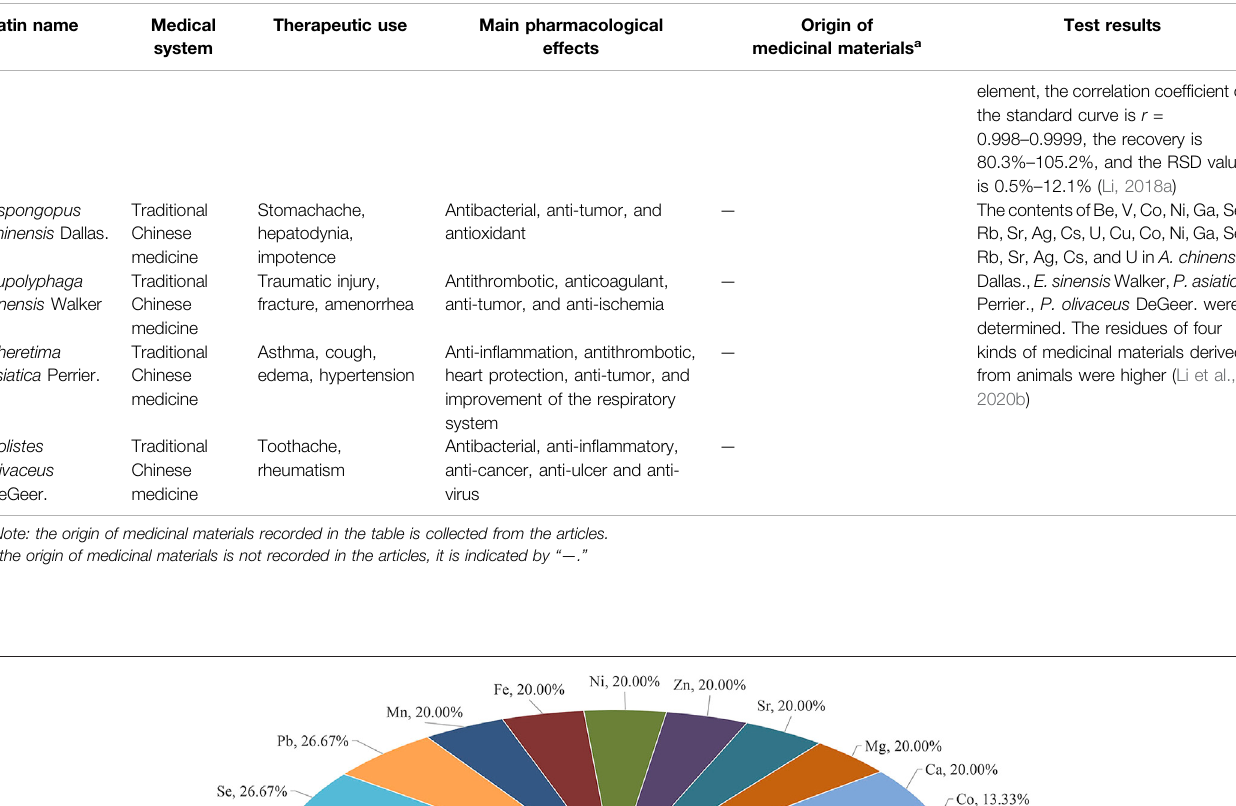
Frontiers in Pharmacology |